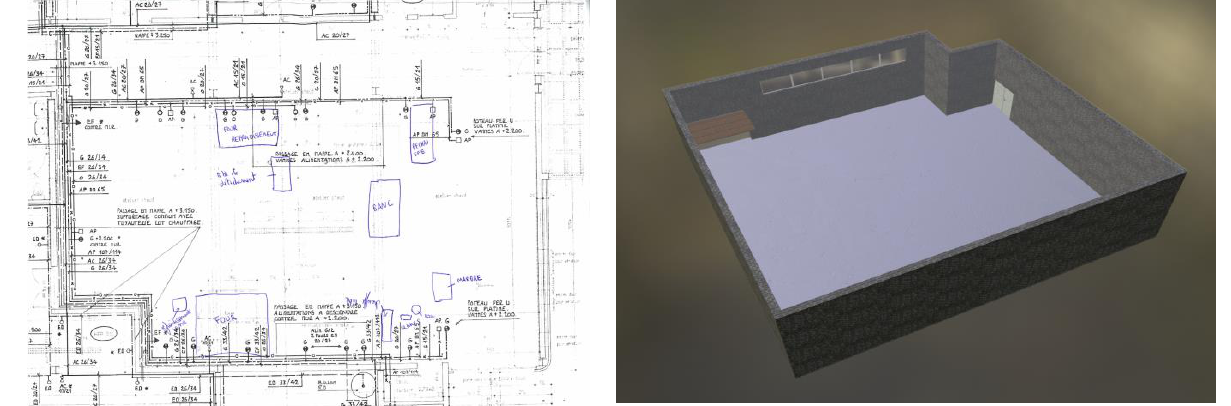
Figure 11. Left: Blueprint survey plan of the glass workshop. Right: 3D model.